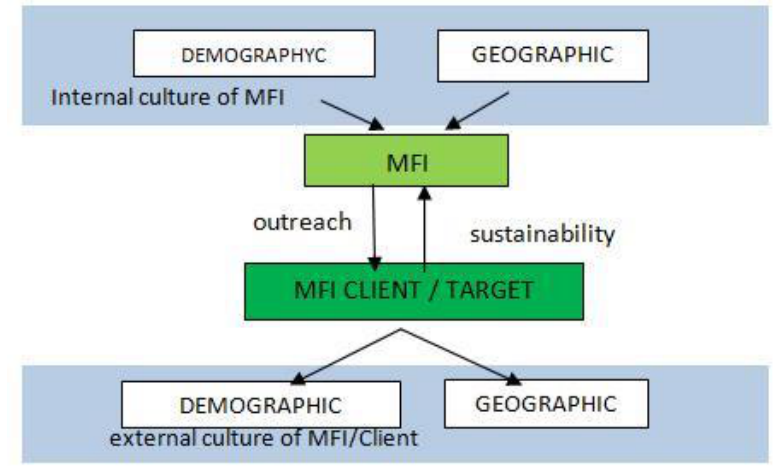
Figure 1 Cultural aspect of microfinance institution (LAZ)